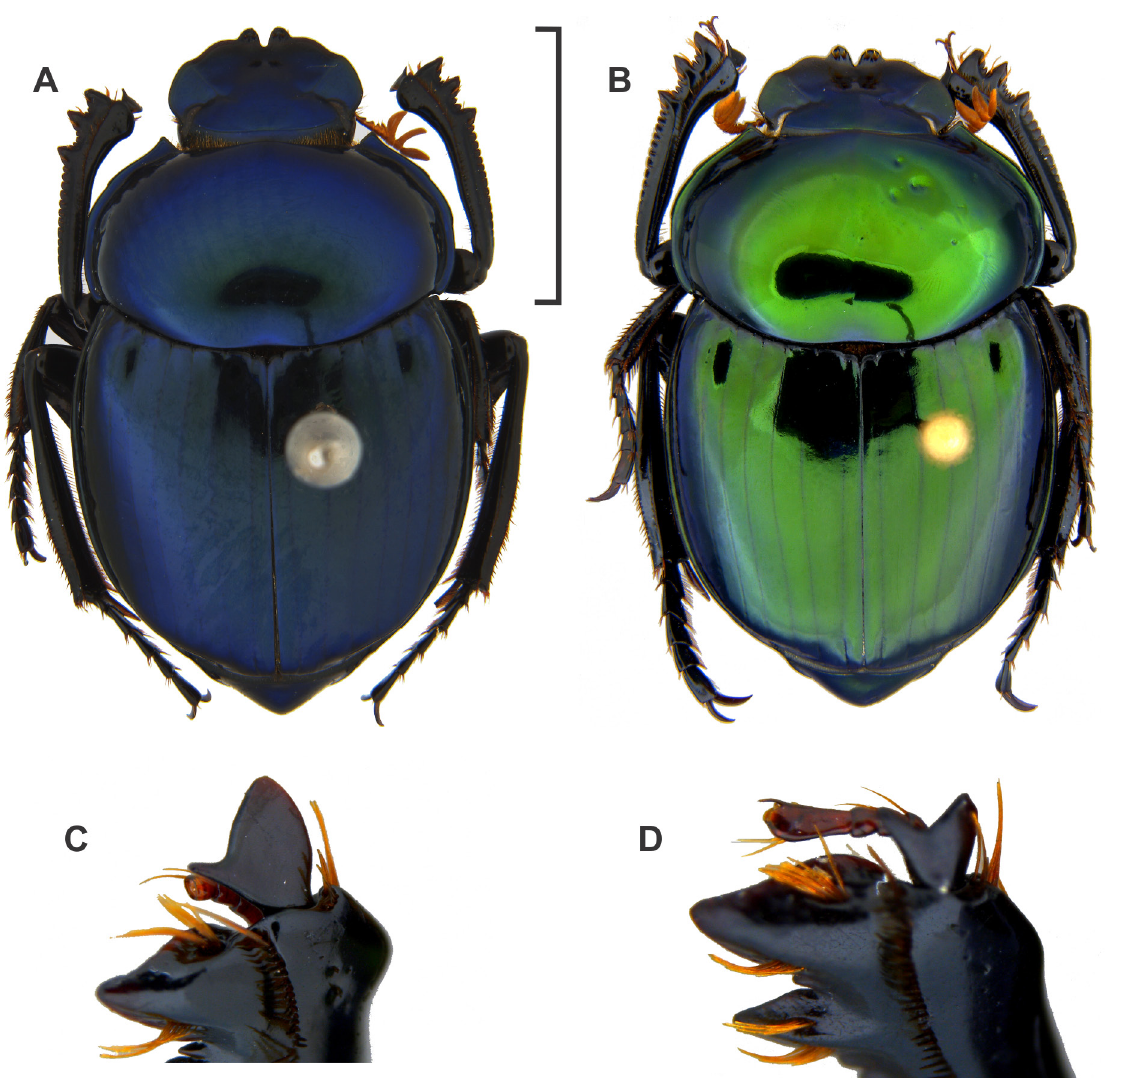
Fig. 2. A . Canthon (G.) smaragdulus smaragdulus (Fabricius, 1781). – B–D . C. (G.) smaragdulus subviridis Schmidt, 1922 stat. rev. A–B . Habitus. C . Male protibial spur. D . Female protibial spur. Scale bar: A–B = 5.0